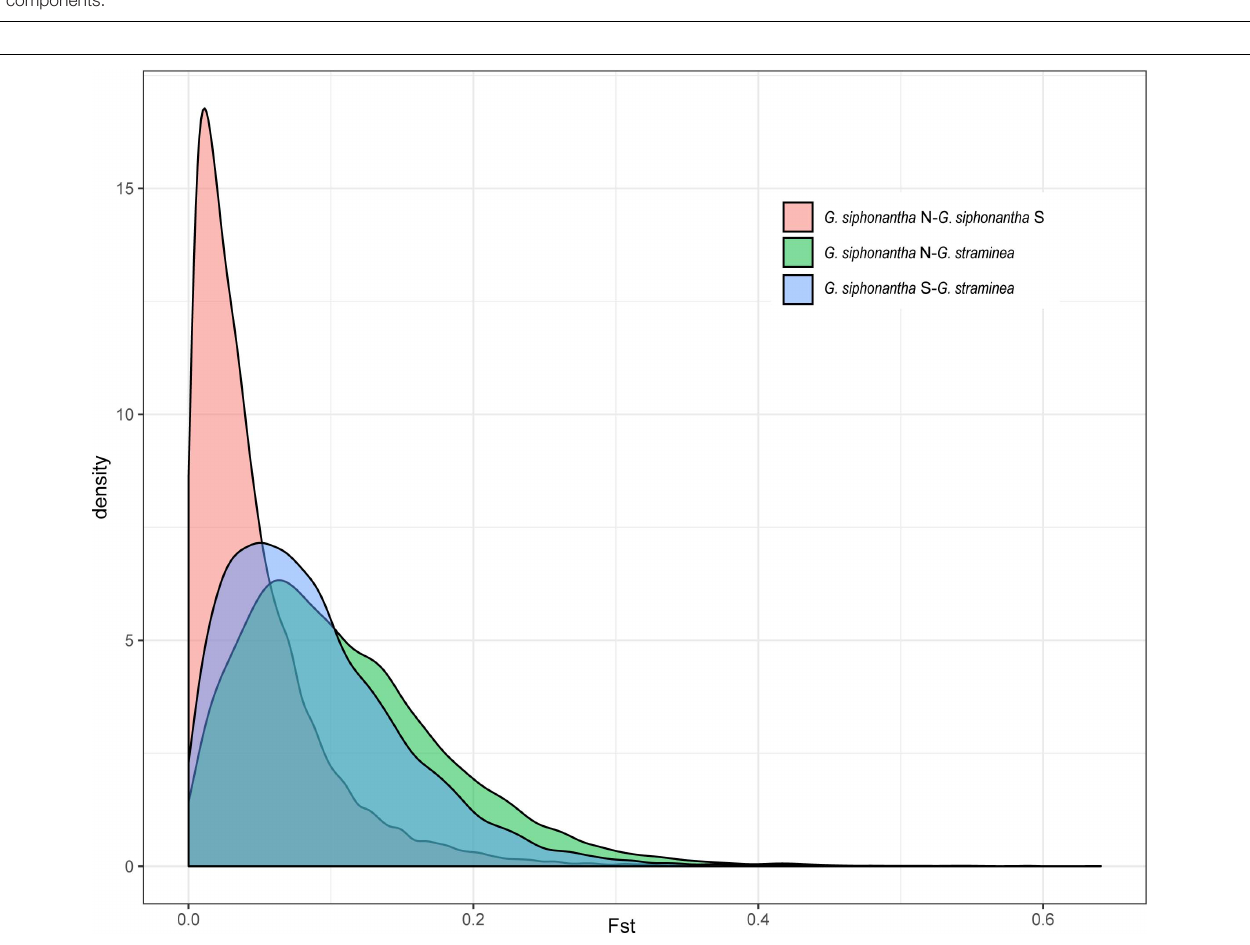
FIGURE 3 | Distribution of genetic differentiation ( F ST ) among the northern and southern populations of Gentiana siphonantha and G. straminea based on nuclear SNP dataset.